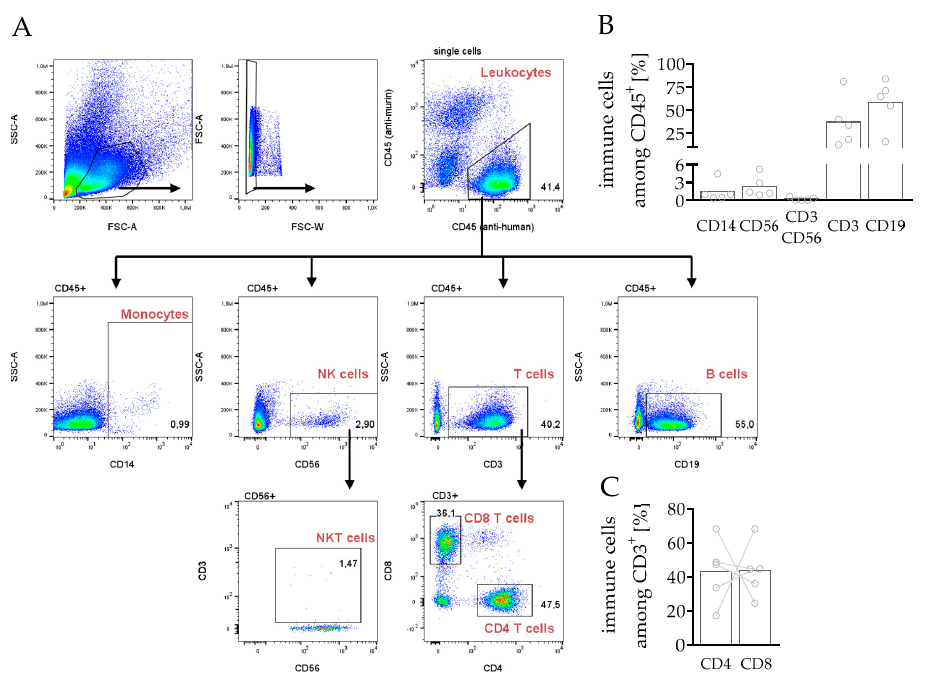
Figure 2. Immune profiling and gating strategy for phenotyping general leukocyte subpopulations in spleens of hPDXs. PDX tumors from breast cancer patients were transplanted orthotopically in humanized NSG mice. Spleens were harvested and processed to a single cell suspension. ( A ) Manual gating strategy for flow cytometry analysis of human splenocytes was as follows: singular (FSC-A FSC-W low ) leukocytes (CD45 + , human) were analyzed free from murine CD45 + cells regarding monocytes (SSC-A low CD14 + ), NK cells (CD56 + ), NKT cells (CD56 + CD3 + ), T cells (CD3 + ), CD4 T cells (CD3 + CD4 + ), CD8 T cells (CD3 + CD8 + ) and B cells (CD19 + ). ( B , C ) Immune cell composition in spleens is shown. Each circle symbol represents one individual mouse (mean, n = 5).